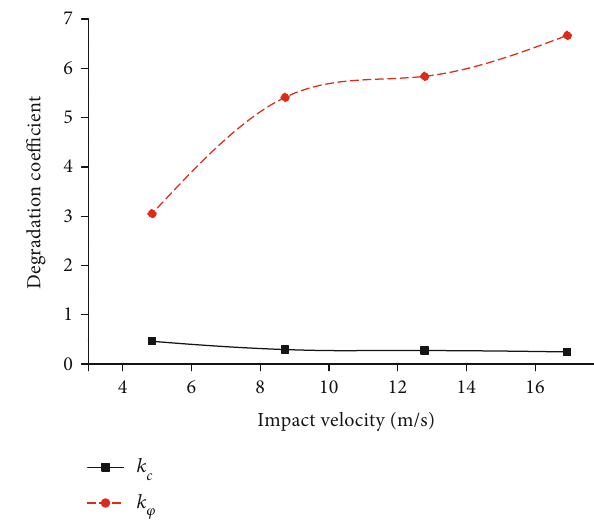
Figure 6: Curves of stress versus time with di ff erent impact velocities. Figure 7: Curves of degradation coe ffi cient versus impact